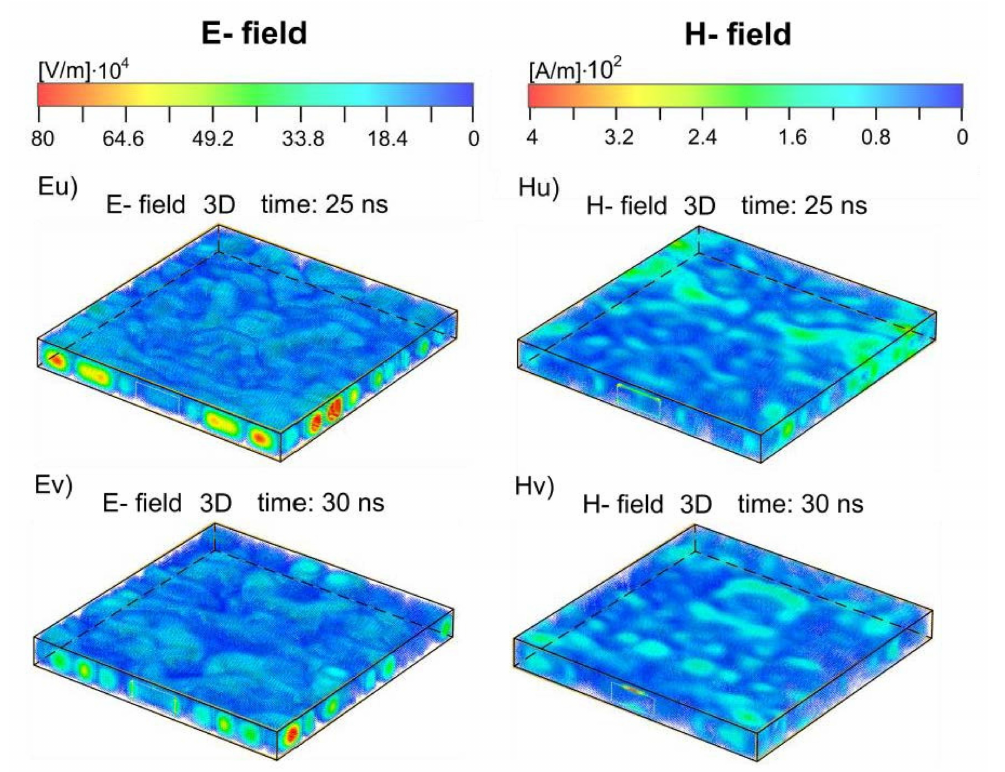
Figure 5. 3D development of the electric and magnetic fields in the enclosure. ( Ea – Ev ) the electric field amplitude; ( Ha – Hv )—the magnetic field amplitude. The current position of the incident HPEM pulse is shown on the upper wall of the enclosure. E1, E2, E3, E4—the interference electric field structures. H1, H2, H3, H4—the interference magnetic field structures. The positions of the electric charges Q i + and Q i − (i = 1, 2, 3, 4, 5, 6) at t = 0.51 ns, t = 0.56 ns, and t = 1.5 ns are shown in Figure